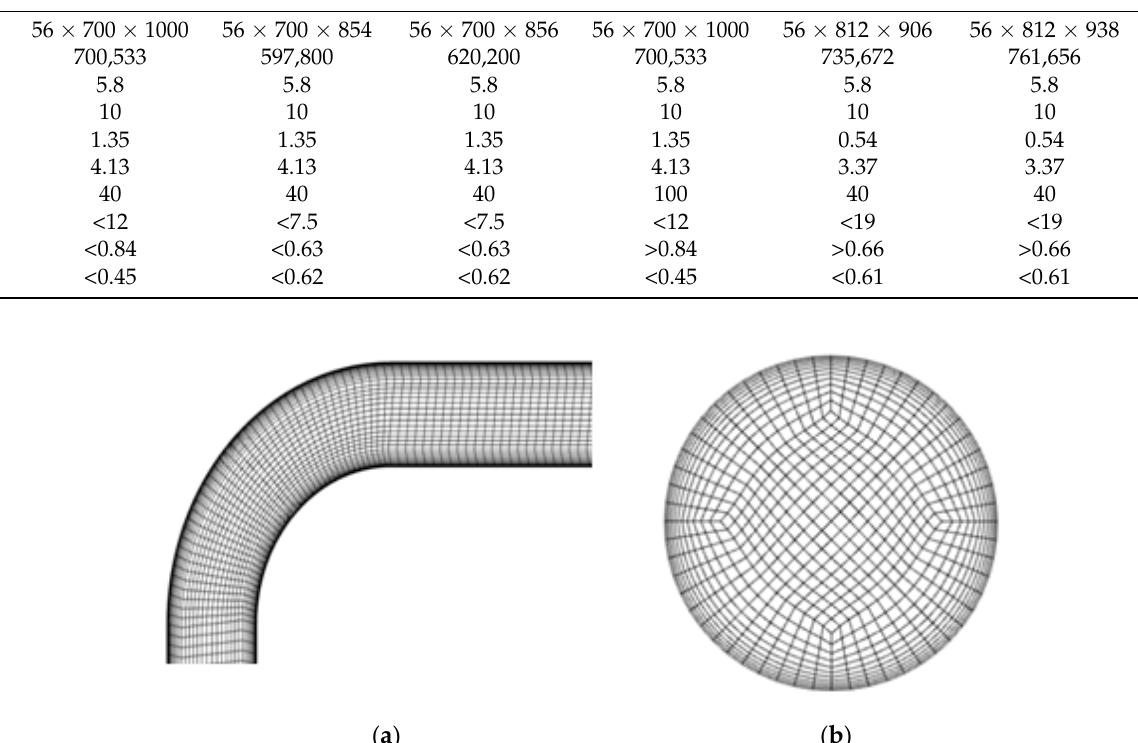
transport phase and discrete phase were used (Sections 2.2.1 and 2.2.2). Table 5 shows the number of elements used in each case and their characteristic dimensions, and Figure 9 shows an example of the type of mesh constructed. Table 5. ∆ x = azimuthal, ∆ y = radial and ∆ z = axial mesh grid size used and the number of elements in each direction N x , N y , N z , respectively. In the radial direction, a mesh refinement was made close to the wall, starting with ∆ y min increasing towards the center until reaching ∆ y max with a growth factor of 1.2.